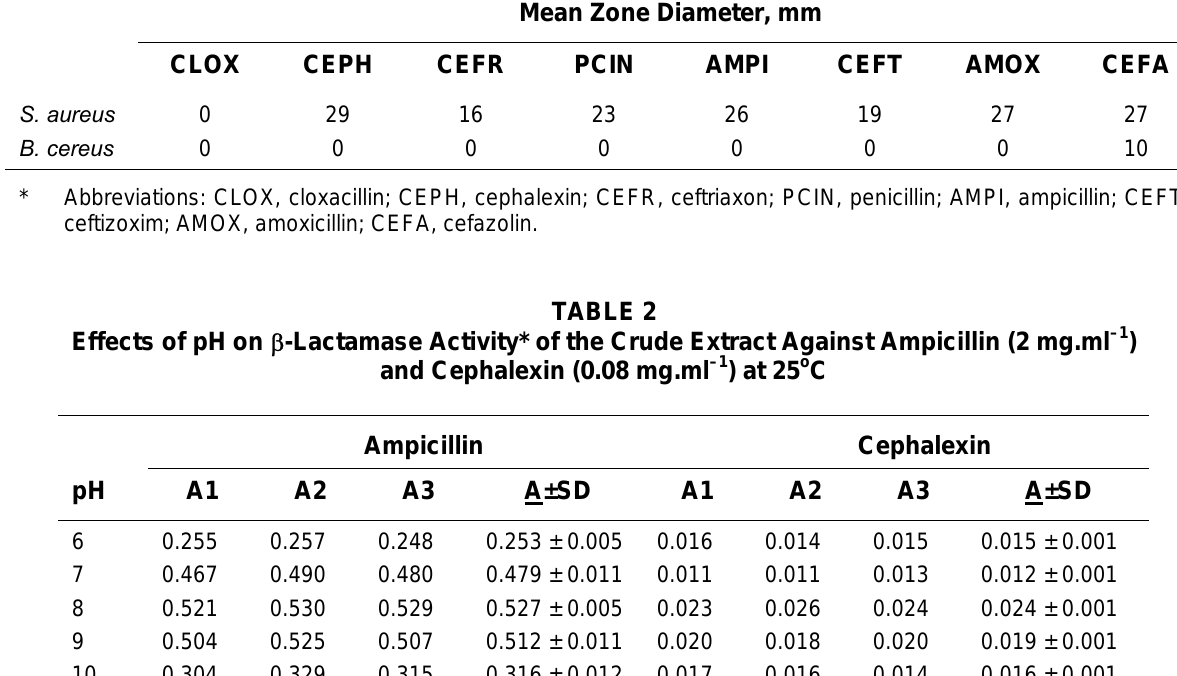
Inhibition Zone Diameter of Some β -Lactam Antibiotics* for B. cereus PTCC 1015 and S. aureus